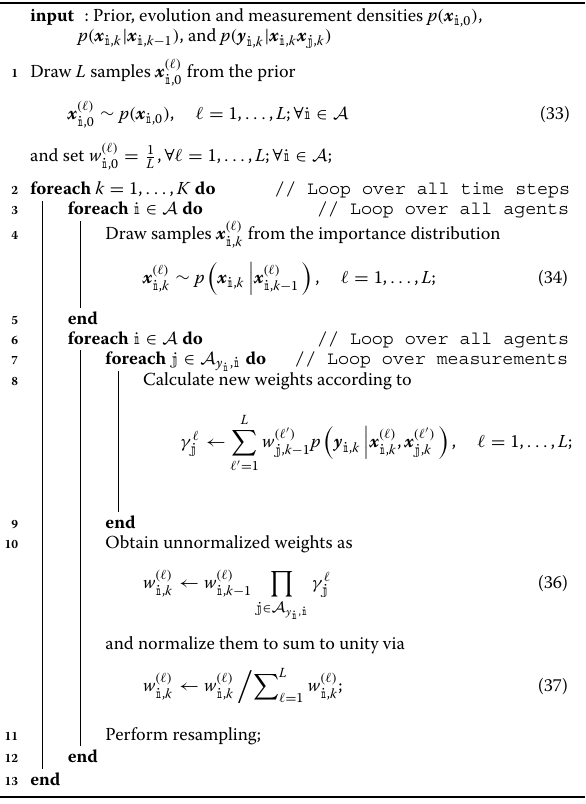
Algorithm 2: Particle Filter with proposed Likelihood Approximation for Multiple Particle